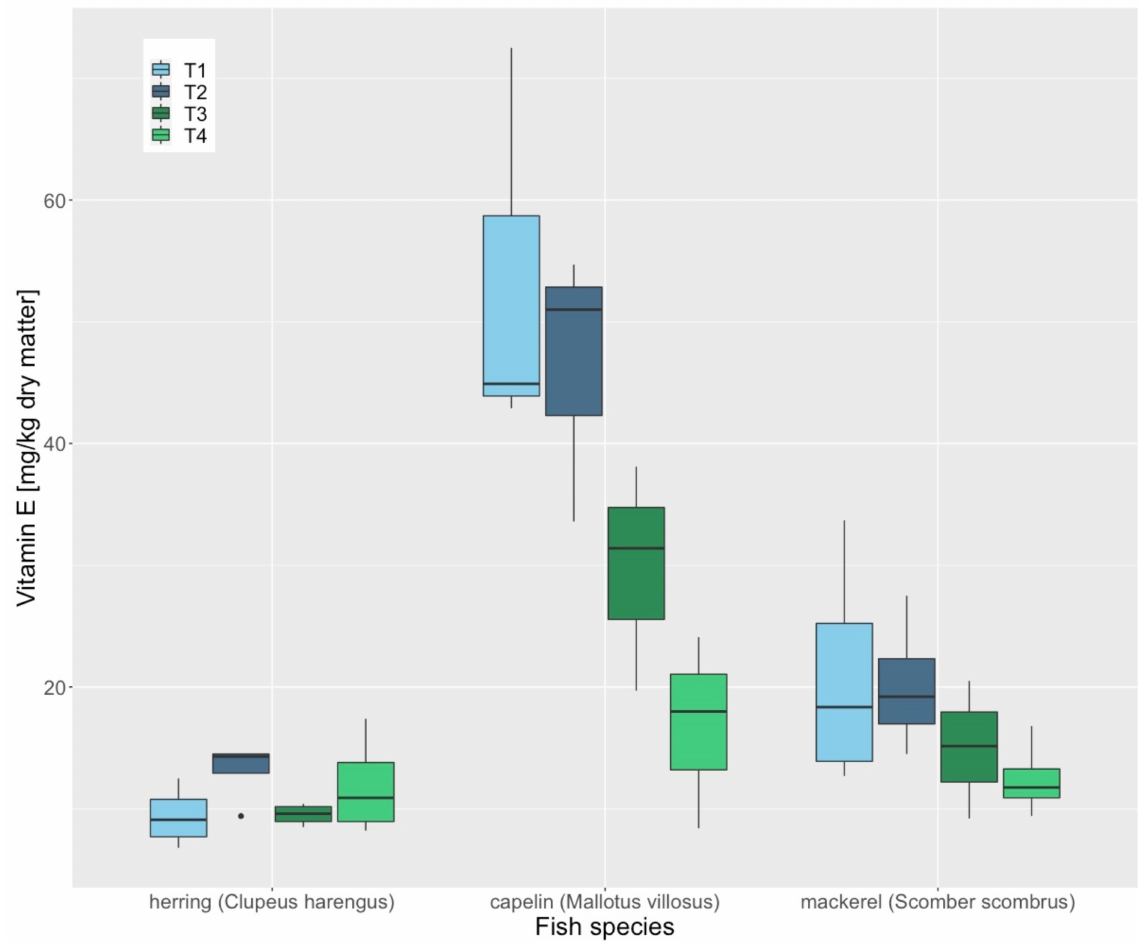
Figure 3. Vitamin E concentrations of whole frozen herring (Clupeus harengus), mackerel (Scomber scombrus) and capelin (Mallotus villosus), thawed in the refrigerator (4 ◦ C for 24 h), measured at 4 different time points. T1 is day of delivery, T2, 60 days after, T3, 120 days after, T4, 180 days after delivery. “ • ” are